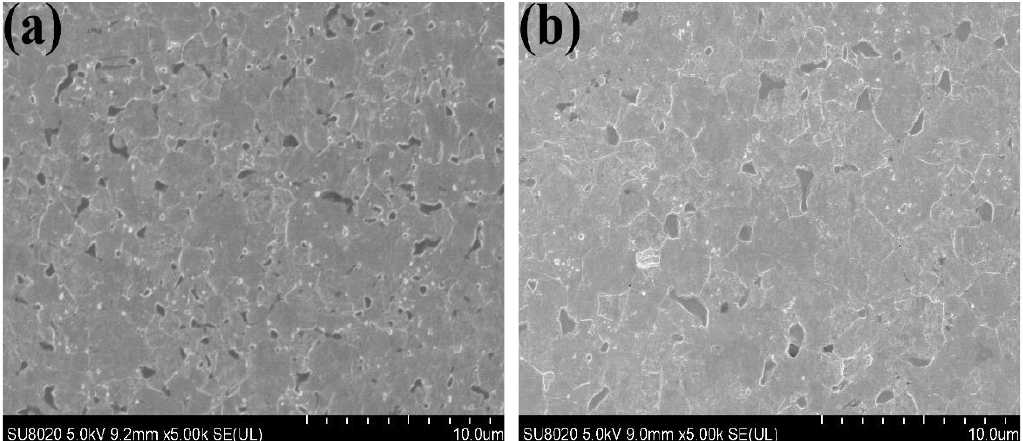
Figure 2. SEM micrographs showing the polished and etched surfaces of ( a ) W-1wt%TiC, ( b ) W-1wt%ZrC.